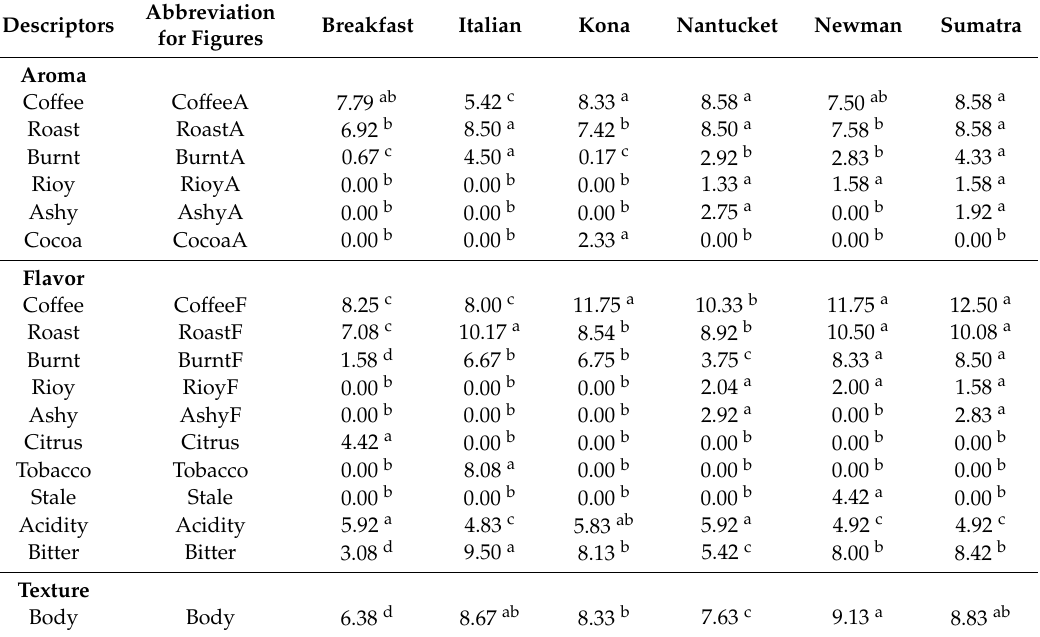
Table 2. The mean scores of the descriptive analysis of the coffee samples.